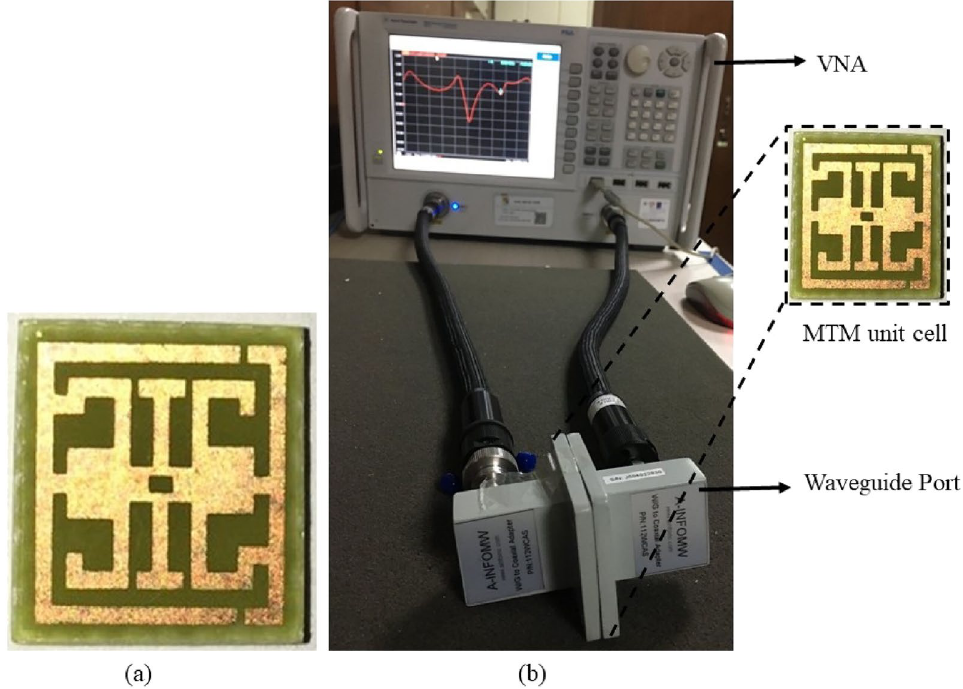
Figure 13. ( a ) Fabricated prototype of structure, ( b ) VNA setup for